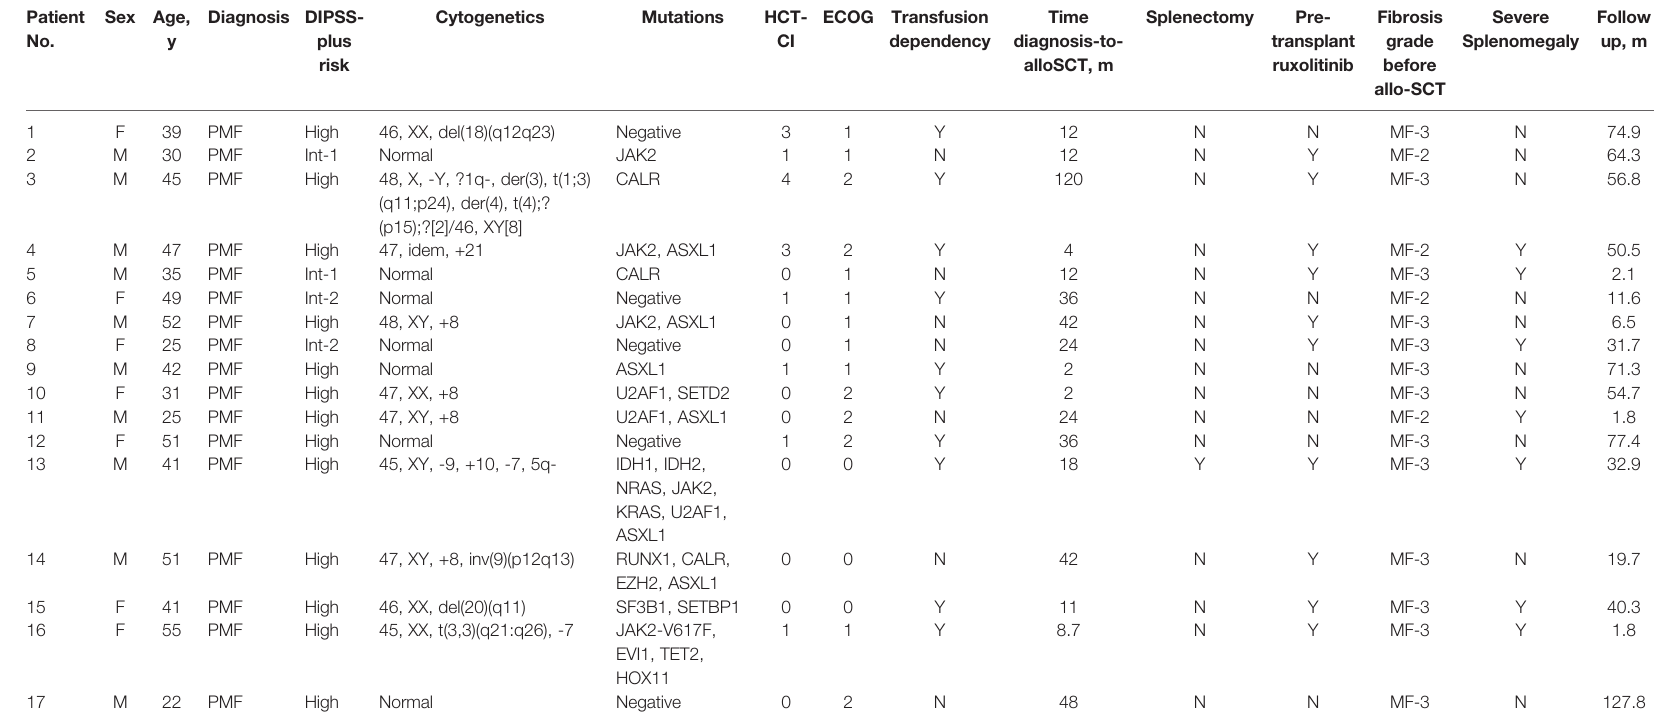
TABLE 1 | Patient- and disease-related characteristics. Patient